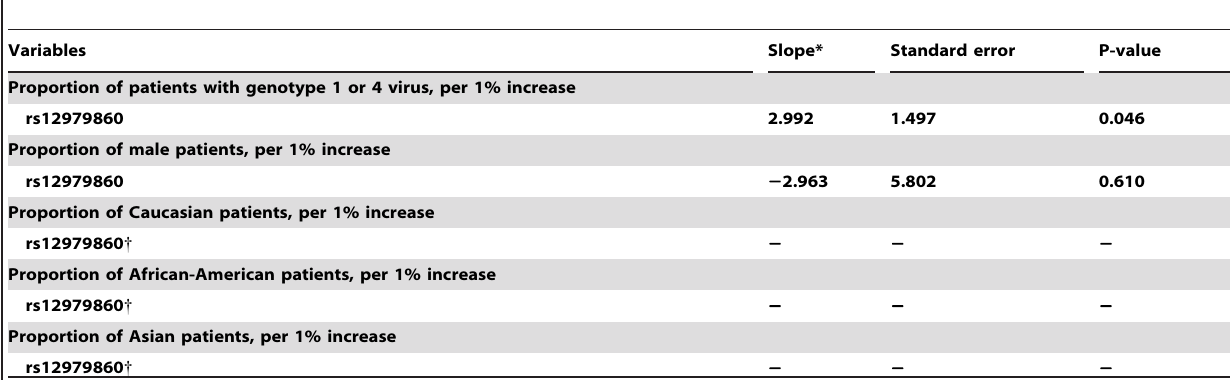
Table 2. Meta-regression analysis between each continuous variable among the studies (only treatment- naı¨ve patients were included) and the effect (log odds ratio) of IL28B polymorphisms on inflammation activity.